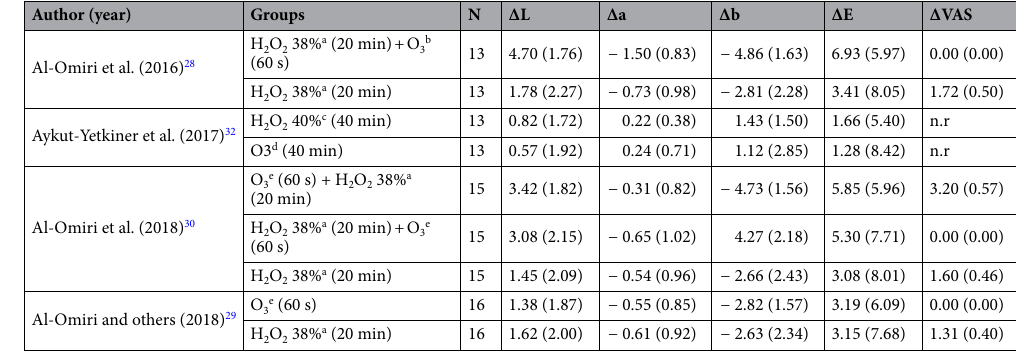
Table 4. Color difference results of the eligible studies and dentin sensitivity. n.r . not reported; ∆E color change variation according to the CIELAB system; ∆L variation of the black/white matrix axis in the CIELAB system; ∆a variation of the red/green matrix axis in the CIELAB system; ∆b variation the of yellow/blue matrix axis in the CIELAB system; VAS Visual Analogue Scale designed as a 10-cm horizontal line with the words “no pain” in one end and “worst pain” in the opposite end; O 3 ozone; H 2 O 2 Hydrogen peroxide.